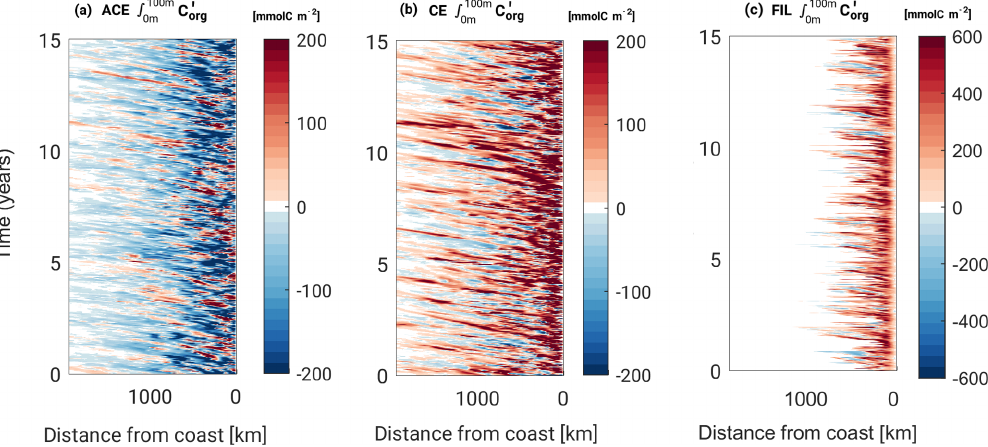
Figure 8. Hovmoeller diagrams of the top 100m stock anomalies of C org in the central CanUS subregion for (a) anticyclones (ACE), (b) cyclones (CE), (c) filaments (FIL). First 15 years of analysis